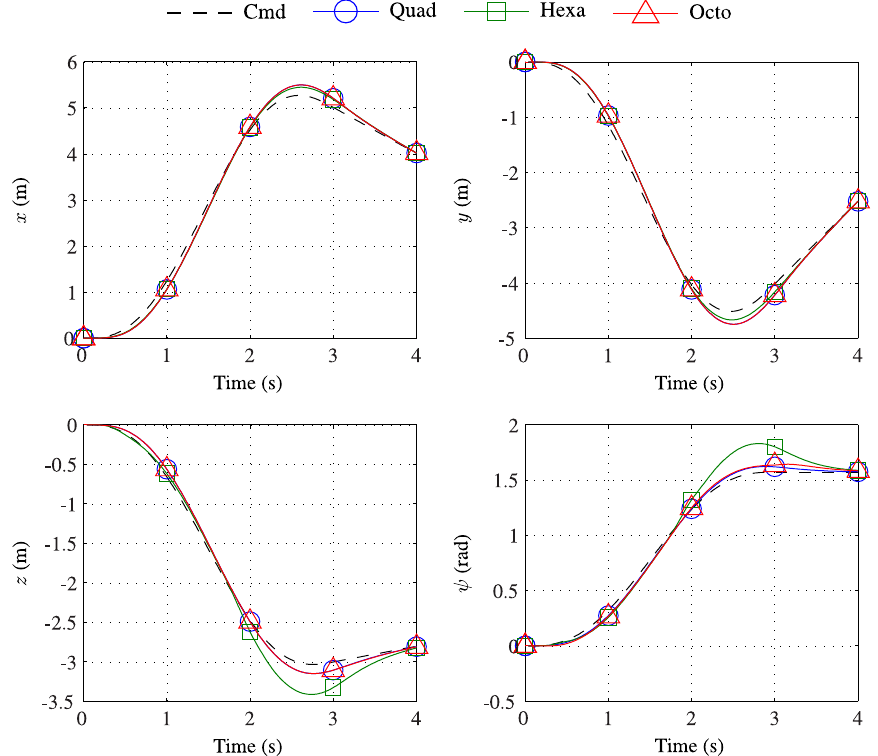
Figure 15. Dynamic response in position and heading for each multirotor when tracking a fast four-dimensional path.